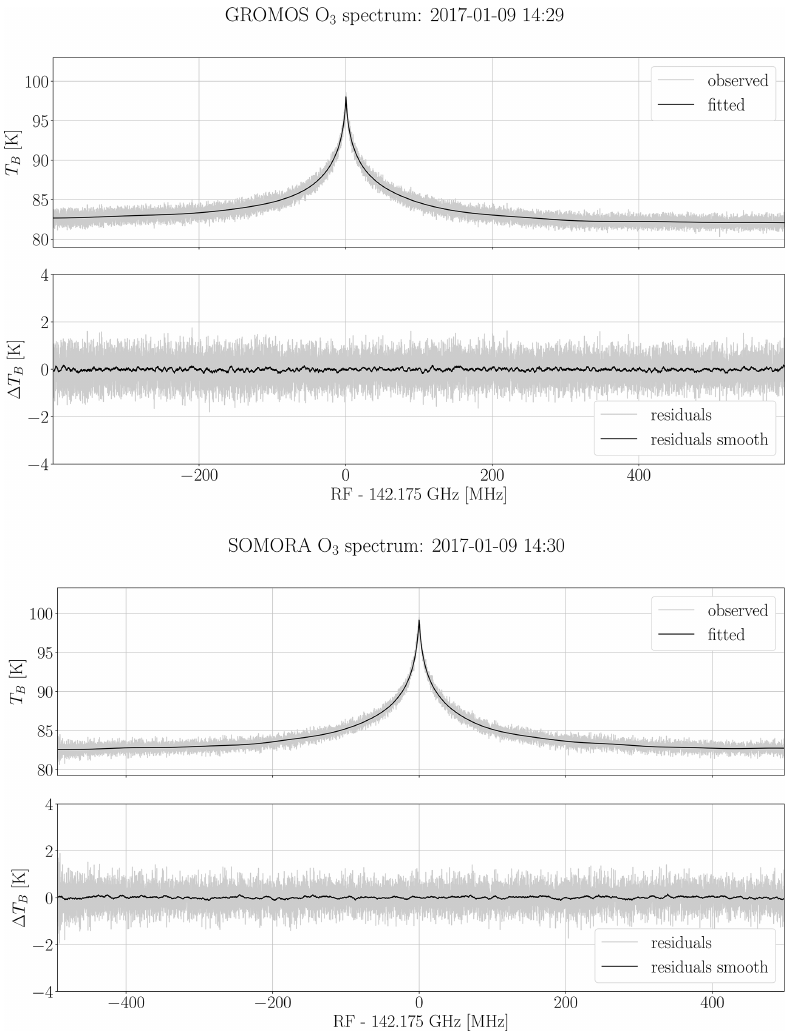
Figure 2. Integrated and fitted spectrum for GROMOS and SOMORA, binned to the same spectral resolution. The lower panels show the residuals, i.e. the differences between the measurement and the fitted spectrum. The smoothed residuals are computed using a running mean over 128 channels. Table 3. Potential error sources and the perturbations used for the sensitivity